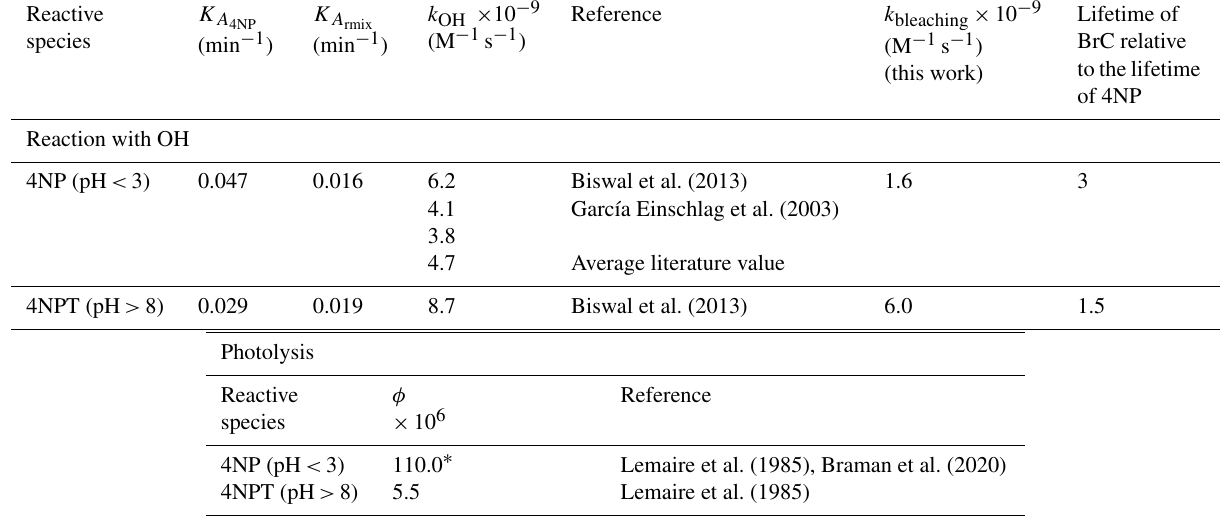
Table 1. The pH-dependent second-order rate constants, empirical bleaching rate constants, and effective quantum yields of photolysis were used to estimate the lifetimes of 4NPs and the corresponding